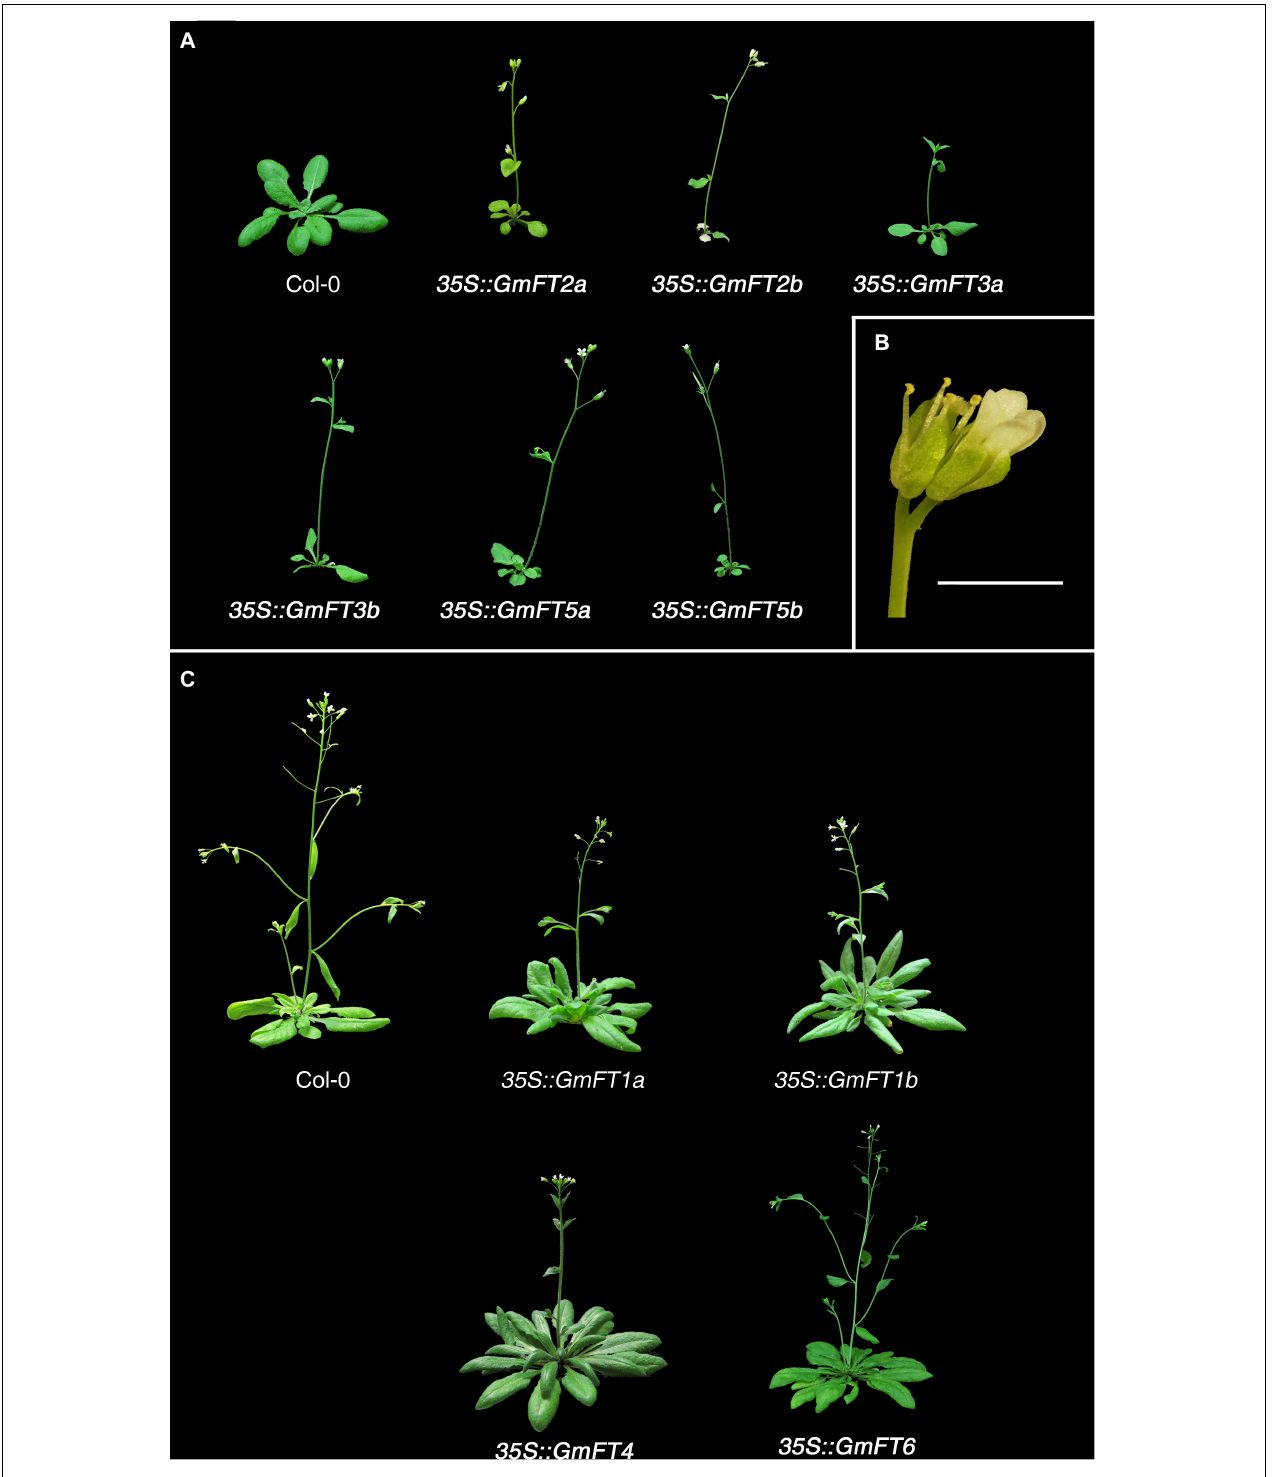
FIGURE 3 | Effects of the ectopic expression of GmFT genes on flowering in transgenic Arabidopsis plants. (A) Phenotypes of 23-day old wild-type (Col-0) and transgenic Arabidopsis plants expressing soybean GmFT2a, GmFT2b, GmFT3a, GmFT3b, GmFT5a , and GmFT5b . (B) Phenotype of terminal flowers of 35S::GmFT2a -expressing Arabidopsis plants. Scale bar is 2 mm. (C) Phenotypes of 40-day old wild-type and transgenic Arabidopsis plants expressing GmFT1a , GmFT1b , GmFT4 , and GmFT6 . Wild-type and T1 transgenic plants were grown on the soil at 23 ◦ C under long-day conditions.